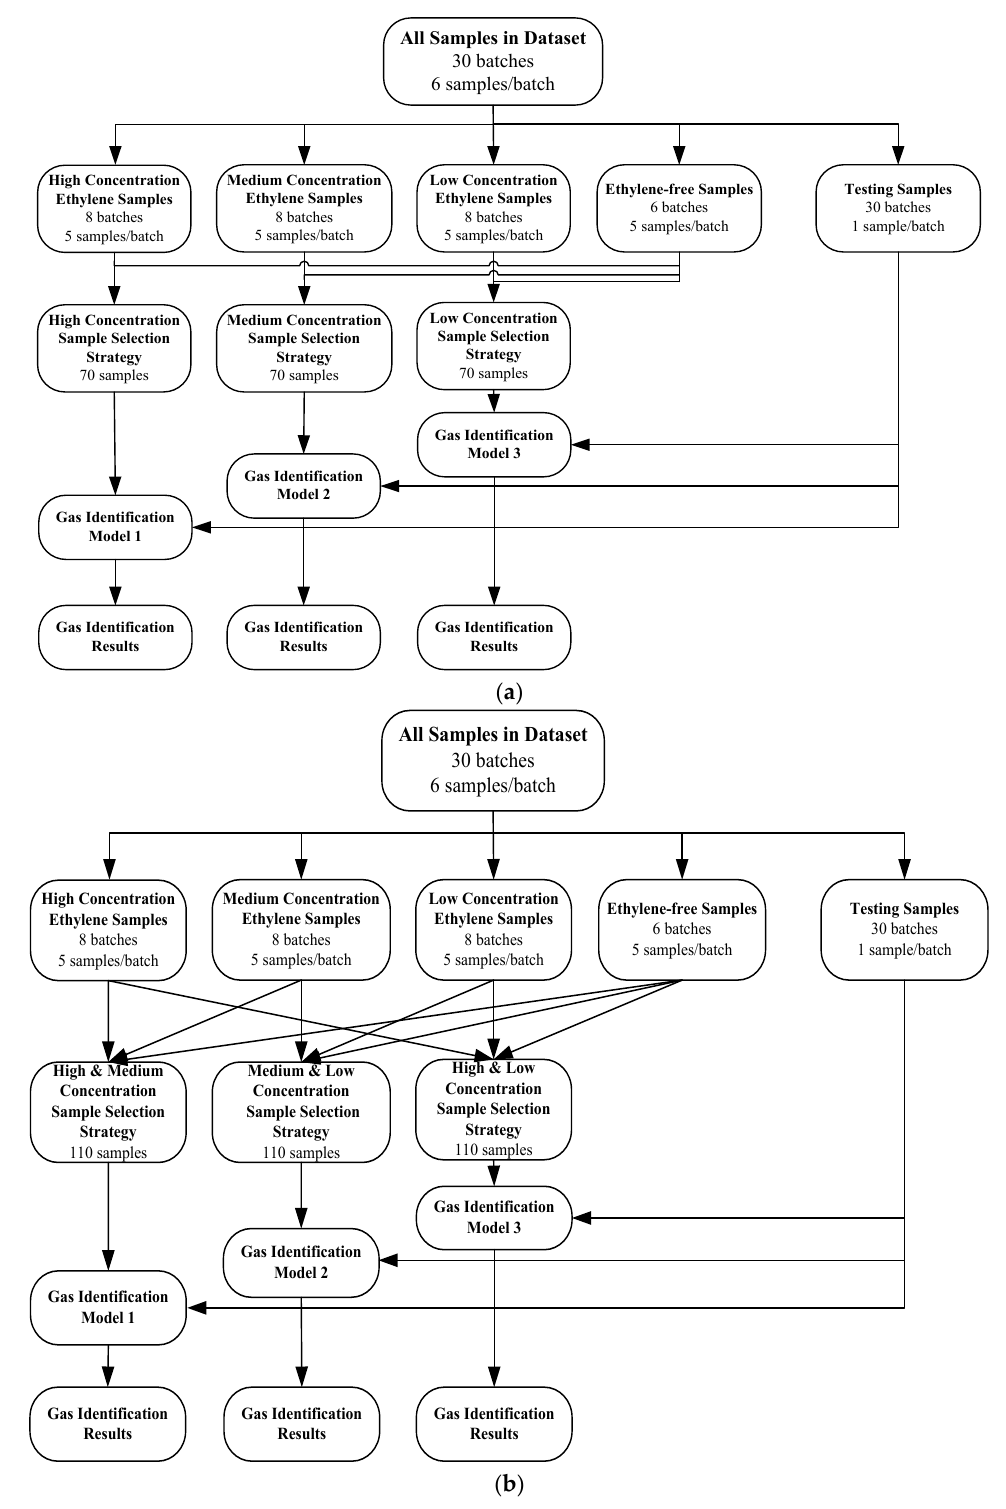
Figure 7. Two different training sample selection strategies for identifying a certain gas compo- nent in the gas mixtures. ( a ) Single-concentration level sample selection strategy; ( b ) compound- concentration level sample selection